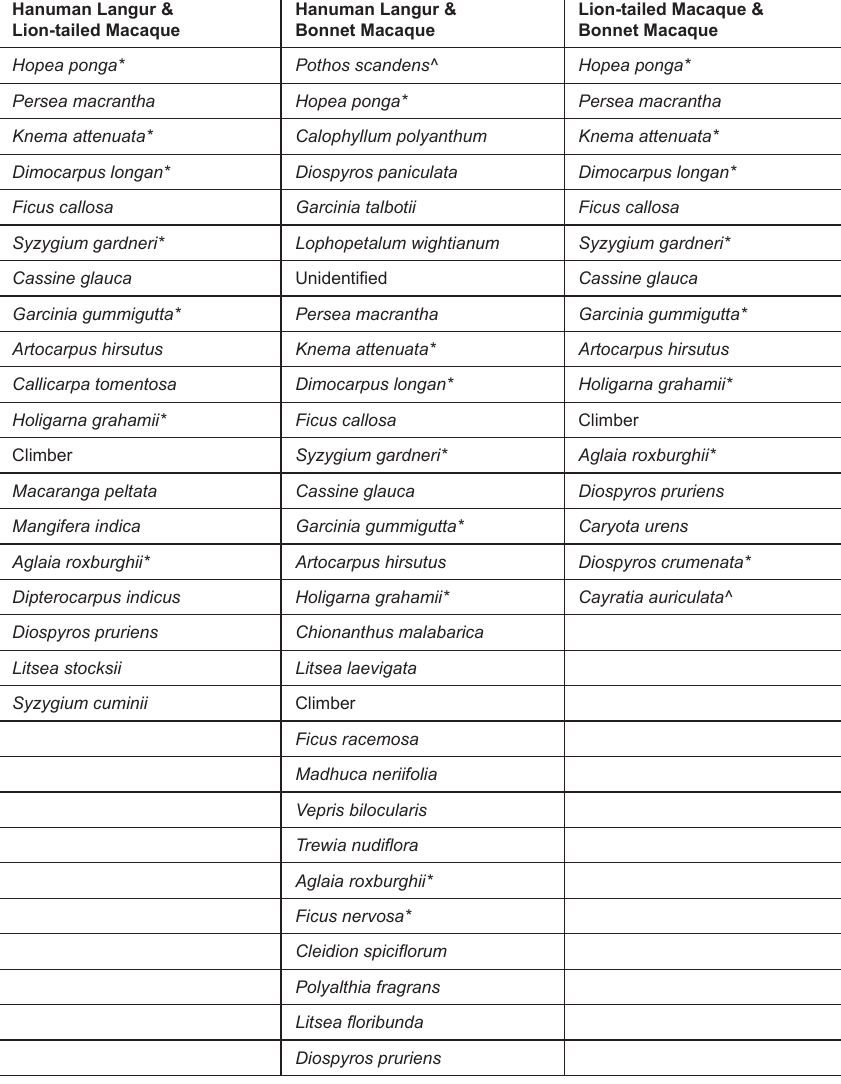
* - High IVI species; ^ - Vegetation other than